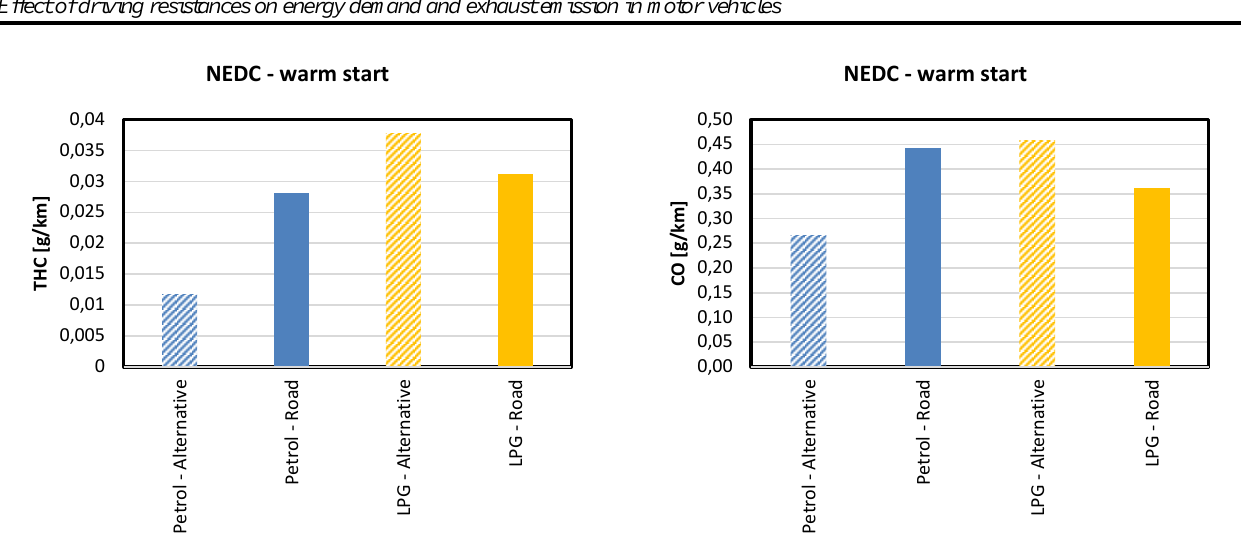
Fig. 9. Impact of resistance forces on THC emissions for NEDC test